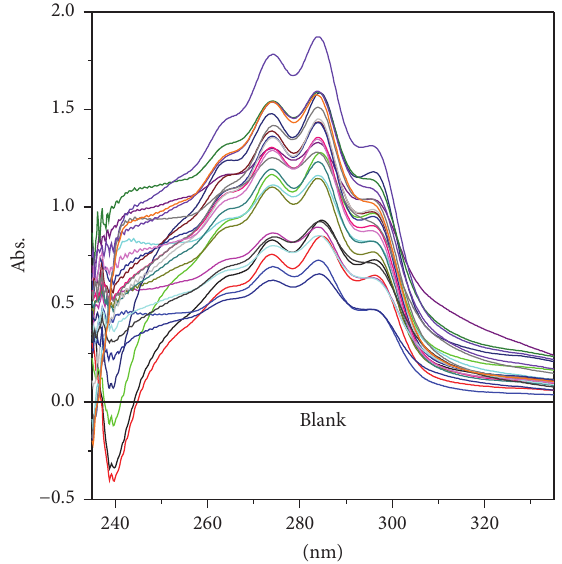
Figure 2: UV spectra fingerprints of the wild edible mushrooms (Boletaceae).